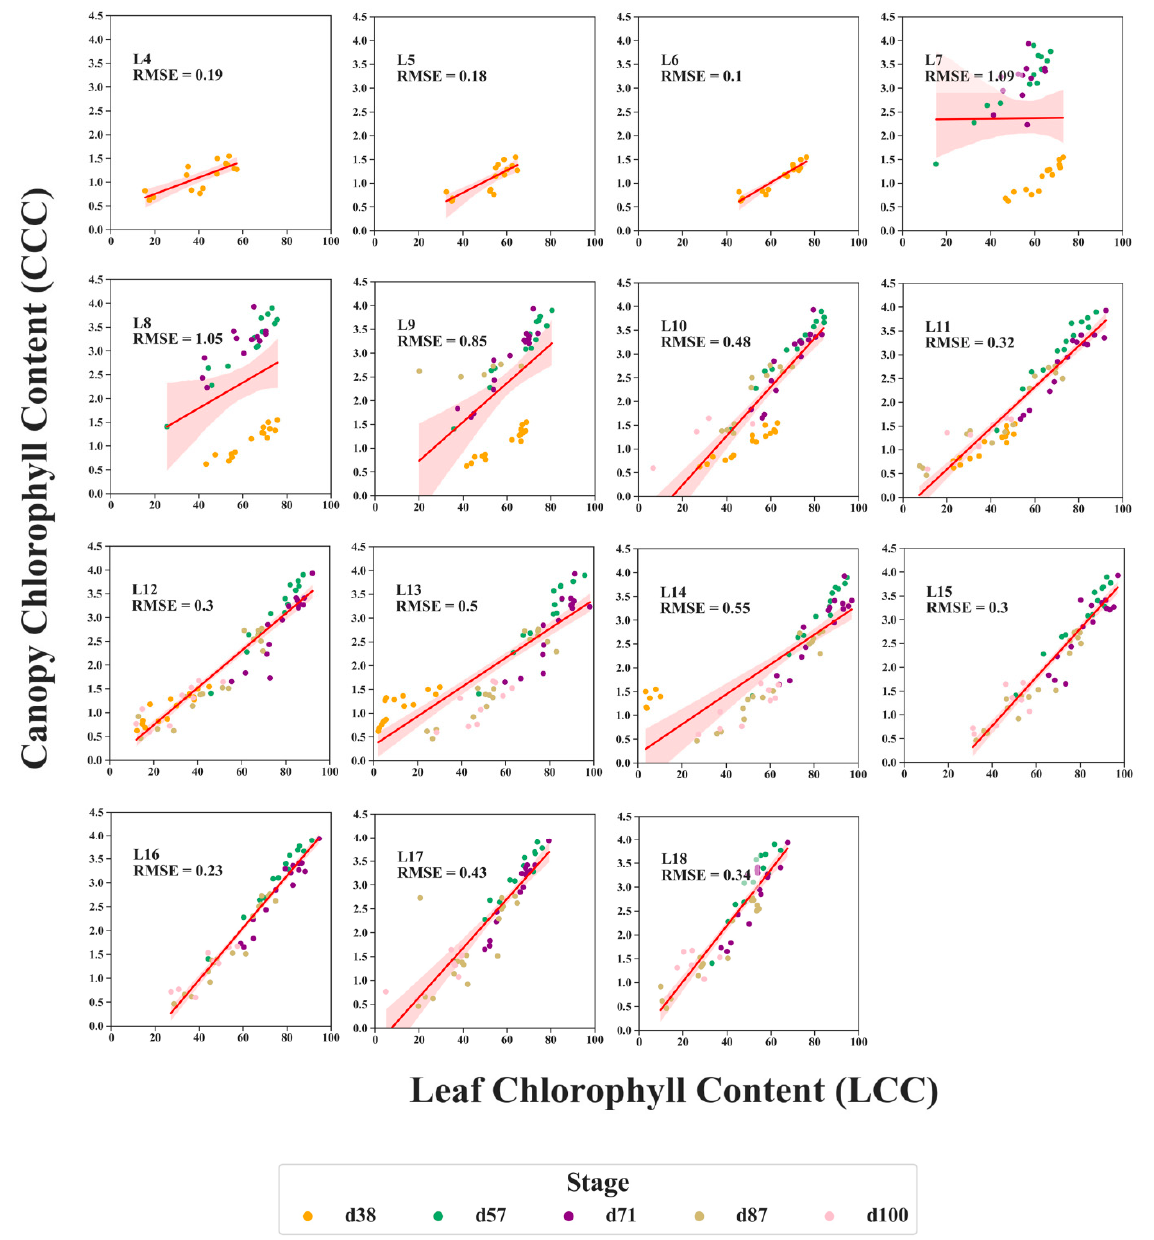
Figure A2. Relationships between the chlorophyll content in the leaf (LCC) and chlorophyll content in the canopy (CCC) at each leaf position and growth stage. Leaf position corresponds to the order of emergence from the bottom to the top of the canopy (L4–L18).